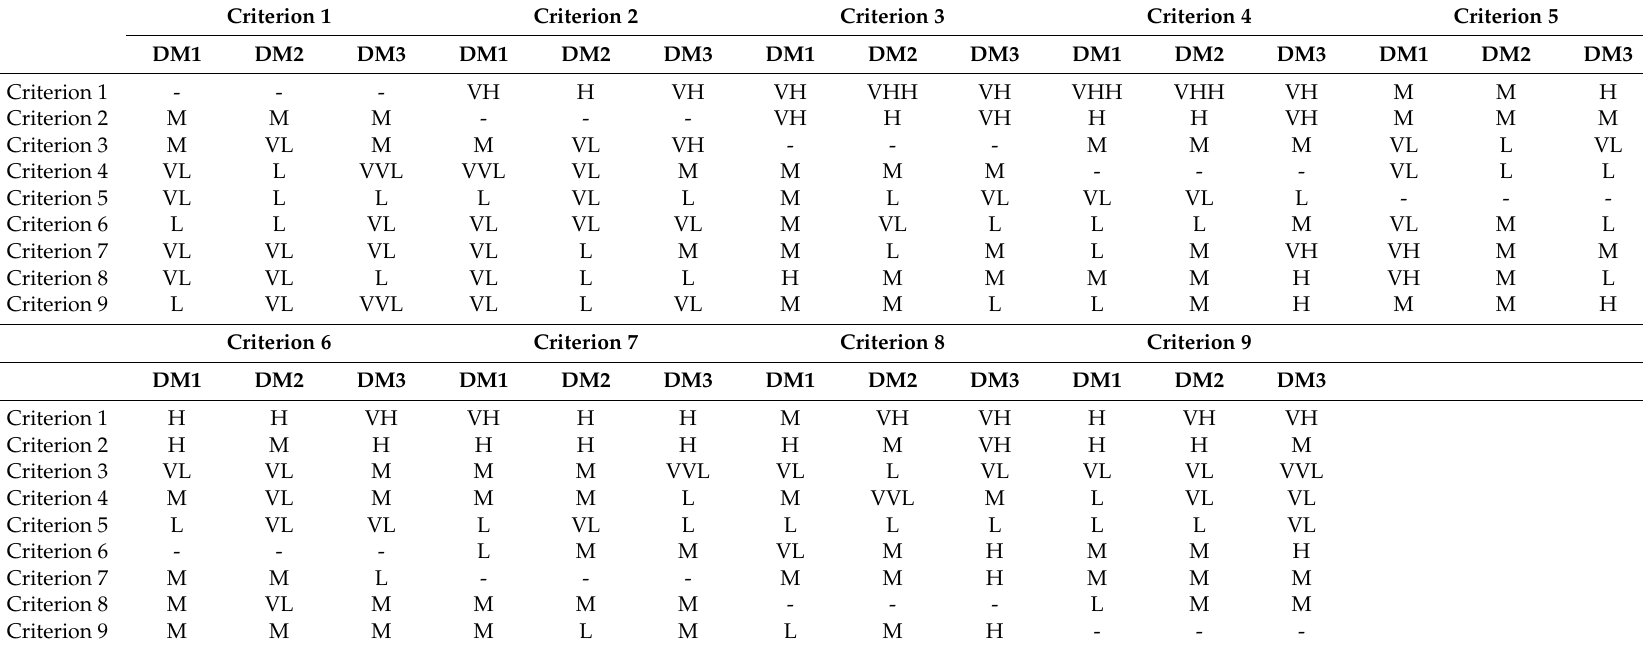
Table A2. Experts’ evaluations for the